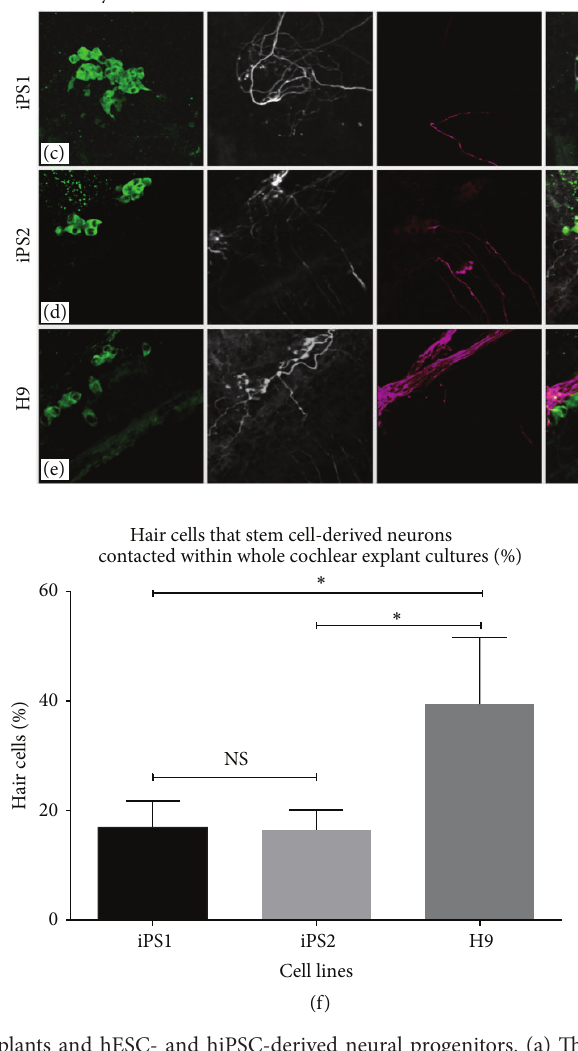
Figure 2: Coculture of cochlear explants and hESC- and hiPSC-derived neural progenitors. (a) The light microscope image depicts the cochlear explant cocultured with a stem cell-derived neurosphere (NS). (b) The explant only control obtained from P3 mice shows the normal innervation pattern of ANs after 1 DIV. (c–e) In cocultures, growth of hESC- and hiPSC-derived neural processes towards and along the rows of the hair cells was observed. Myosin VIIa (green) labels the hair cells, Neurofilament (NFM; grey) labels the endogenous neural processes, and human NFM (hNFM; red) labels the stem cell-derived neural processes. The merged 1 images represent higher magnification images of the boxed inserts and depict the contacts made between the stem cell-derived neural processes and hair cells: for example, three points of contact are shown in (c) merged 1 . Scale bar = 50 𝜇 m, relevant for all the images. (f) The hiPSC-derived neural processes made contact with fewer hair cells compared to the hESCs (iPS1 𝑛 = 16 , 𝑝 < 0.05 ; iPS2 𝑛 = 17 , 𝑝 < 0.05 ; H9 𝑛 = 12 ). There was no significant difference in the number of hair cells making contact with the iPS1 and iPS2 cell lines ( 𝑝 = 0.38 ). A Kruskal-Wallis one-way ANOVA was utilized to determine statistical significance between the groups compared. Data are presented as the mean ± SEM. Values of ∗ 𝑝 < 0.05 were considered statistically significant. NS: not